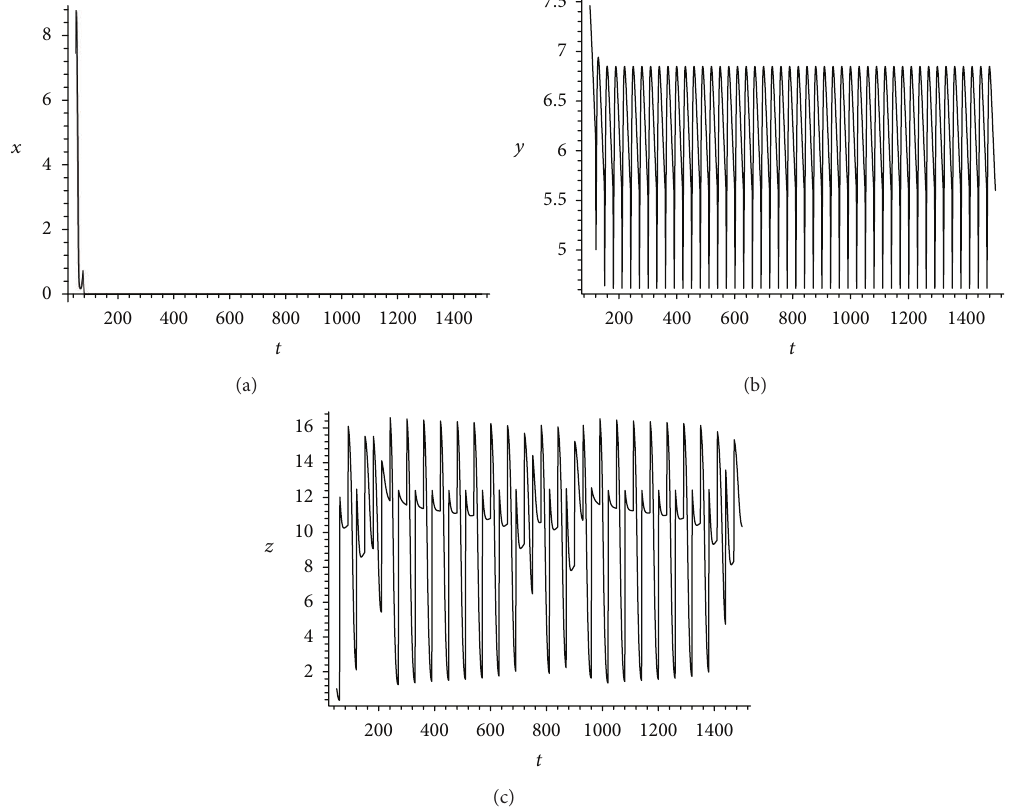
Figure 5: The dynamics of the system (1) with 𝑝 = 5 and 𝛿 3 = 0.6